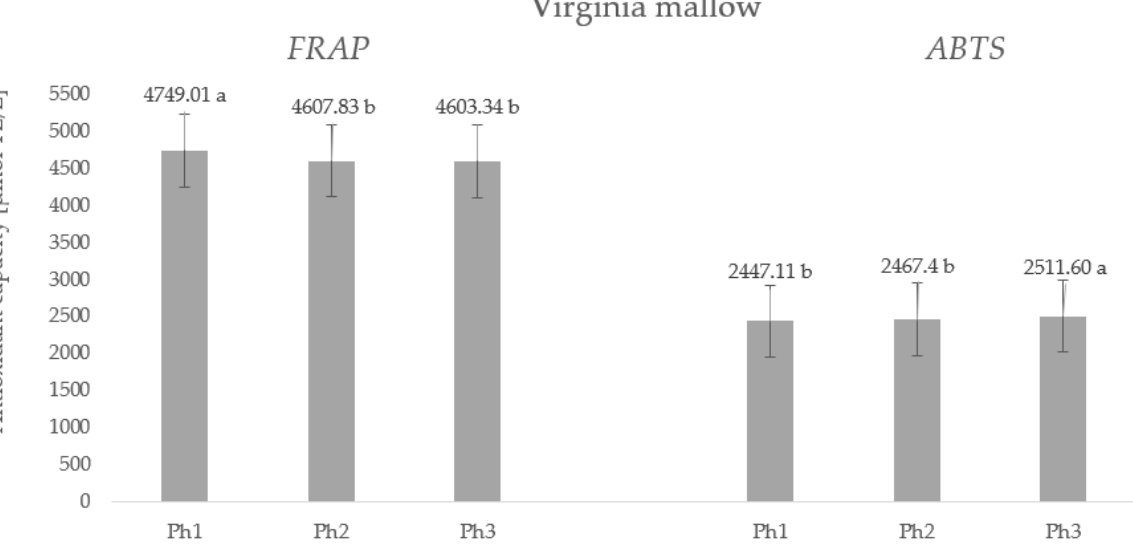
Figure 3. Antioxidant capacity ( µ mol TE/L) of fresh leaf of Virginia mallow. Results are expressed as mean ± standard deviation. Different letters indicate significant differences between mean